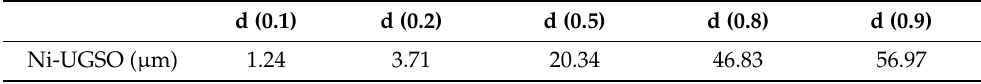
Table 5. Particle size distribution of Ni-UGSO (13